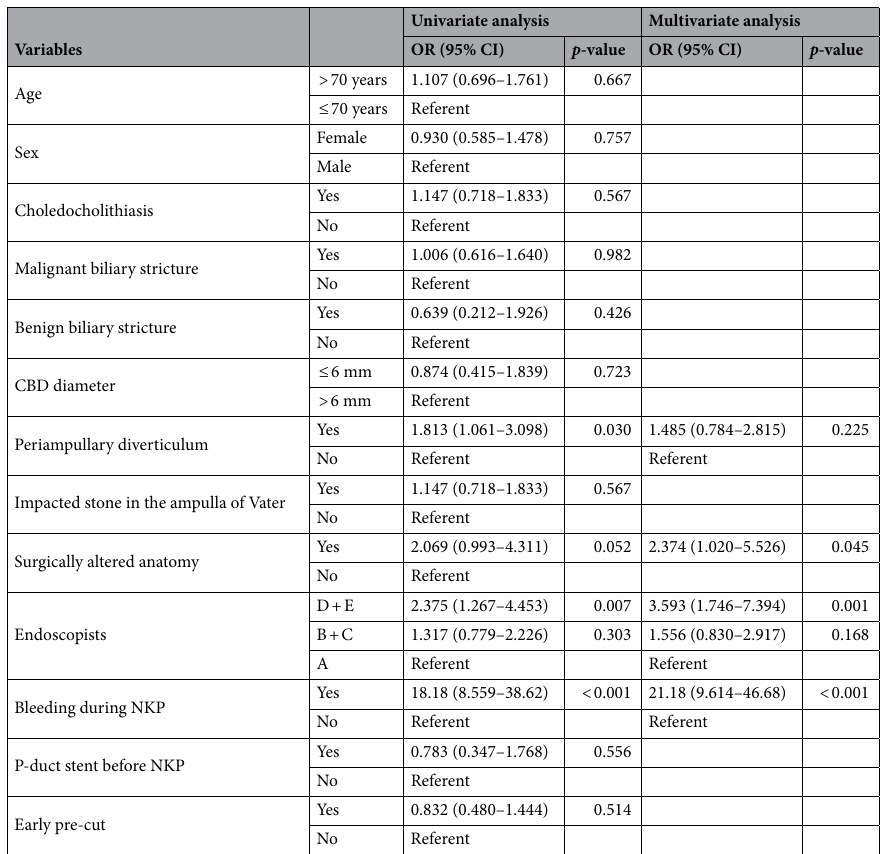
Table 3. Univariate and multivariate analyses of the factors associated with the initial failure of needle-knife pre-cut sphincterotomy. CBD common bile duct, NKP needle-knife pre-cut papillotomy, OR odds ratio, CI confidence interval, P-duct pancreatic